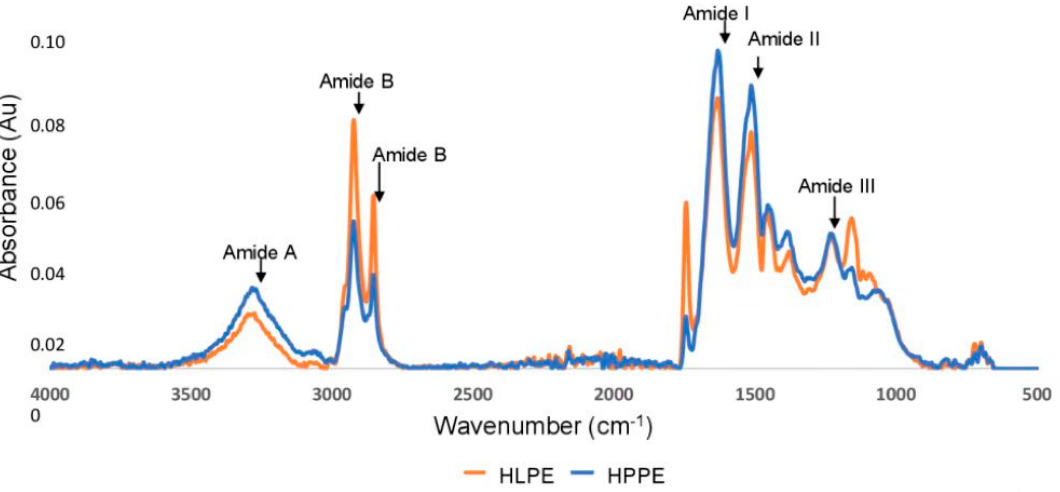
Figure 3. FTIR spectra of the Huhu larvae and pupae protein